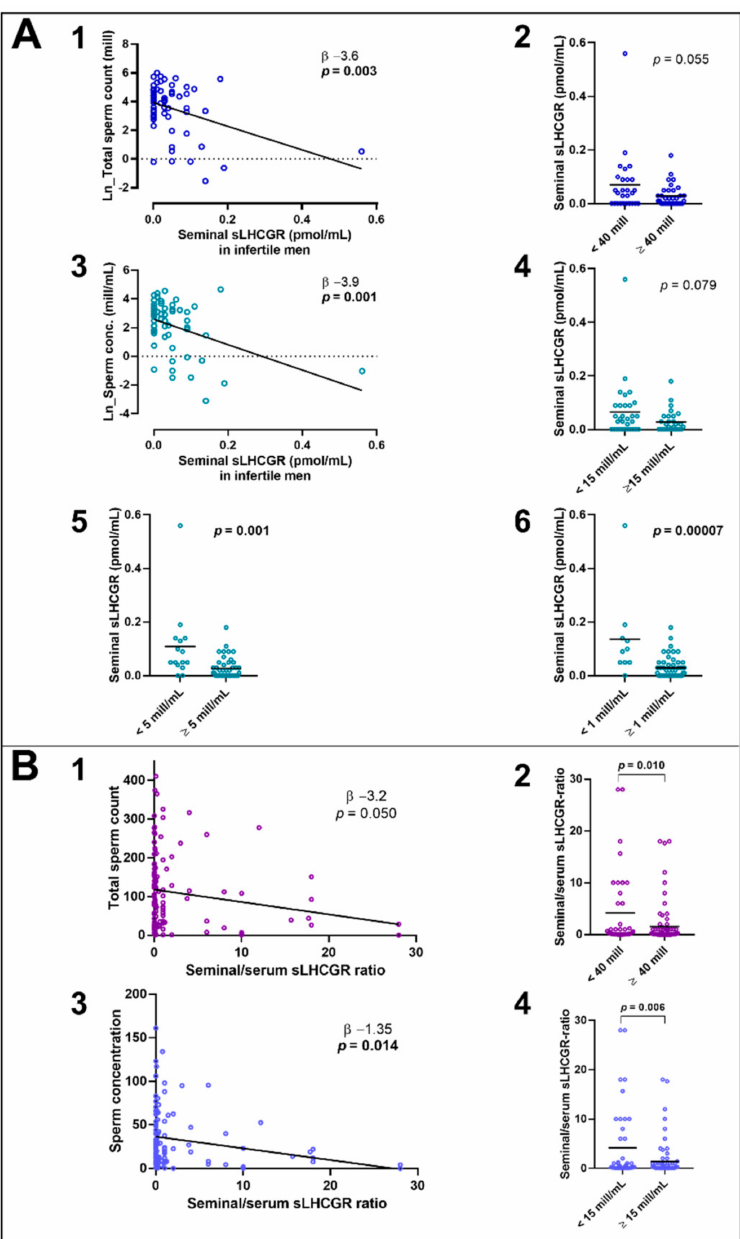
Figure 5. Association between sLHCGR in seminal fluid and semen quality. ( A ): Serum and seminal LHCGR concentration and semen quality in 61 men. A1: Linear regression between total sperm count and seminal sLHCGR-level. A2: Total sperm count cut-off value for low vs. normal (< 40 mill), bar shows mean. A3: Linear regression between sperm concentration and seminal sLHCGR-level. A4: Borderline significantly lower sLHCGR with decreased sperm concentration: cut-off value for low vs. normal (<15 mill/mL). A5: Significantly lower sLHCGR with decreased sperm concentration: cut-off for severe oligospermia (<5mill/mL). A6: Significantly lower sLHCGR with decreased sperm concentration: cut-off of 1 mill/mL, bar shows mean. ( B ): Pooled analyses of seminal sLHCGR data from both healthy and infertile men. B1: Linear regression between seminal/serum sLHCGR-ratio and total sperm count. B2: Significantly lower sLHCGR with decreased sperm concentration: cut-off for low vs. normal total sperm count (<40 mill), bar shows mean. B3: Linear regression between seminal/serum sLHCGR-ratio and sperm concentration. B4: Significantly lower sLHCGR with decreased sperm concentration: cut-off for low vs. normal total sperm concentration (<15 mill/mL). All seminal analyses adjusted for time of